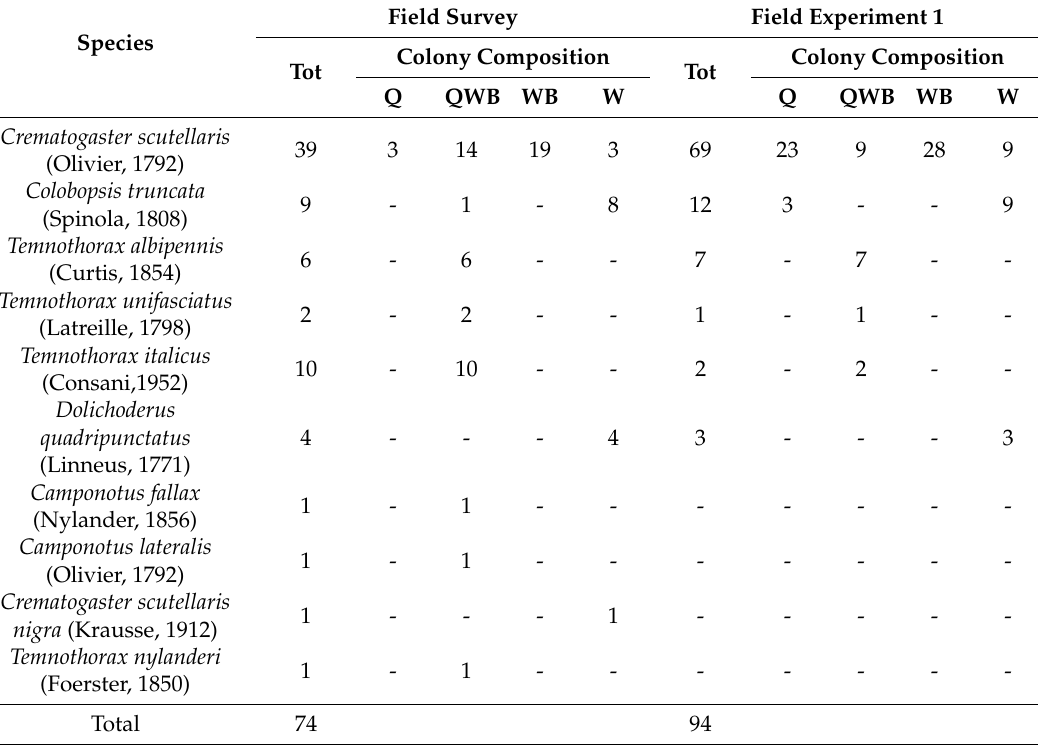
Table 1. Checklist of the ant species collected during the field survey and Experiment 1. The first column (Tot) shows the total number of galls collected for each species. In the Colony Composition section, the number of galls is shown according to the presence of the queen only (Q), queen + workers + brood (QWB), workers + brood (WB), and workers (W) only. Field Survey Field Experiment 1 Species Colony Composition Colony Composition Tot Tot Q QWB